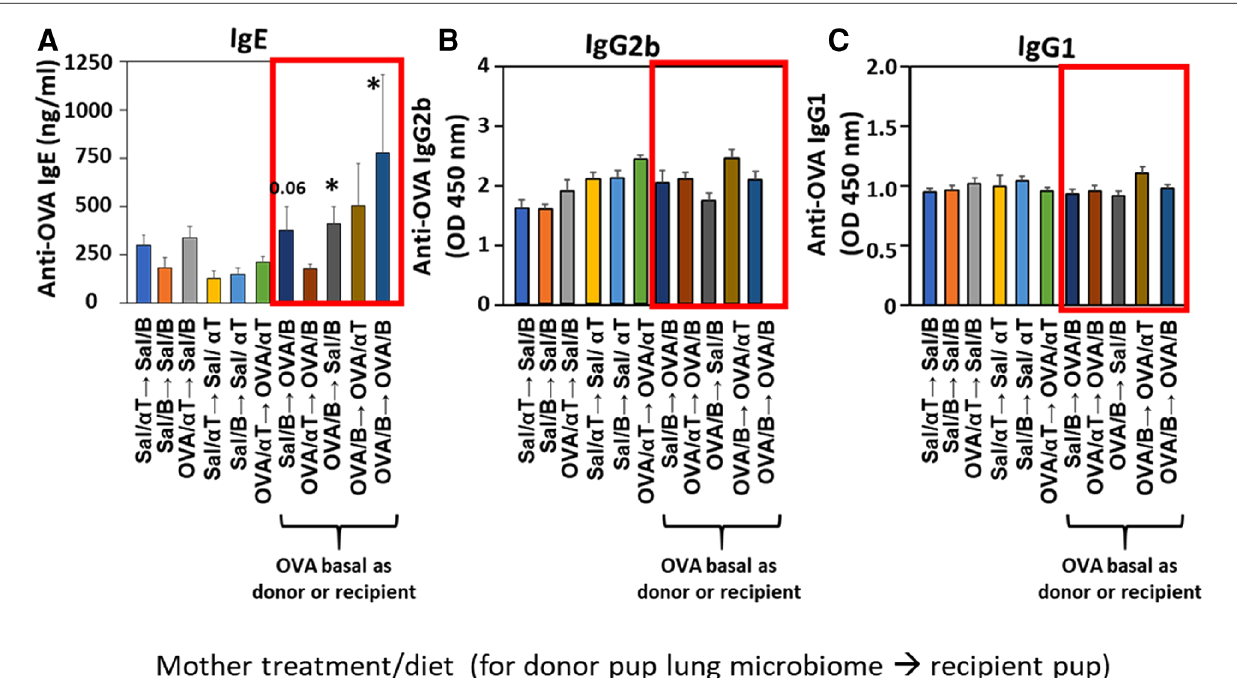
FIGURE 6 Recipient or donor microbiota from pups of allergic mothers (OVA,basal) conferred allergen sensitization with increased IgE but not increased IgG2b or IgG1 (red box). Mice were treated as in timeline in ( Figure 4A ). Serum ( A ) anti-OVA IgE, ( B ) anti-OVA IgG2b, and ( C ) anti-OVA IgG1 as determined by ELISA. Data are presented as mean±SEM. N =6 – 9/group. Sal/B, saline-treated mother with basal diet. Sal/ α T, saline-treated mother with α T-supplemented diet. OVA/B, OVA allergen-treated mother with a basal diet. OVA/ α T, OVA allergen-treated mother with α T-supplemented diet. * p <0.05 as compared to the saline,basal → saline,basal group. + p <0.1 as compared to no donor → Saline/basal